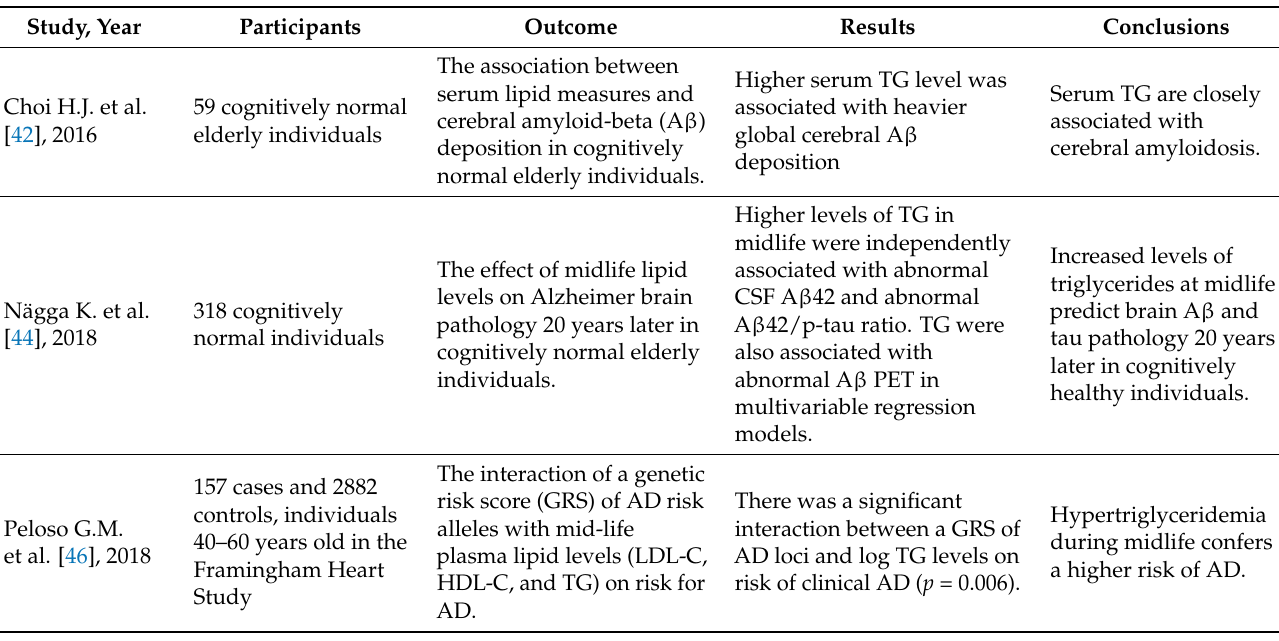
Table 2. Characteristics of some relevant clinical studies concerning triglycerides and cerebral amyloidosis. Study, Year Participants Outcome Results